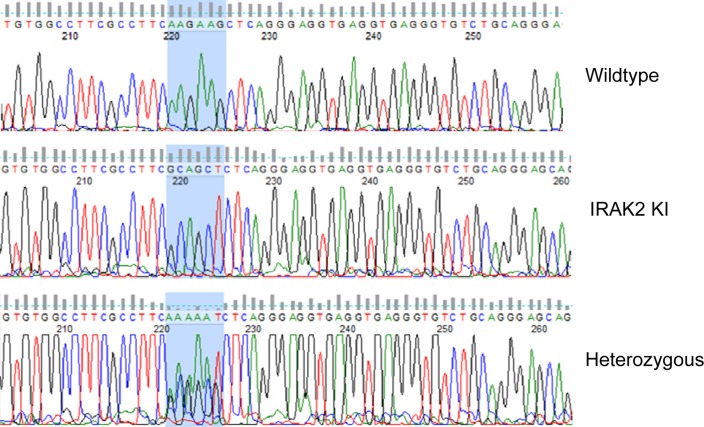
Sequencing analysis of wild-type, IRAK2 kinase-inactive (IRAK2 KI) and heterozygous mice.AAGAAG was mutated to GCAGCT (highlighted in blue).